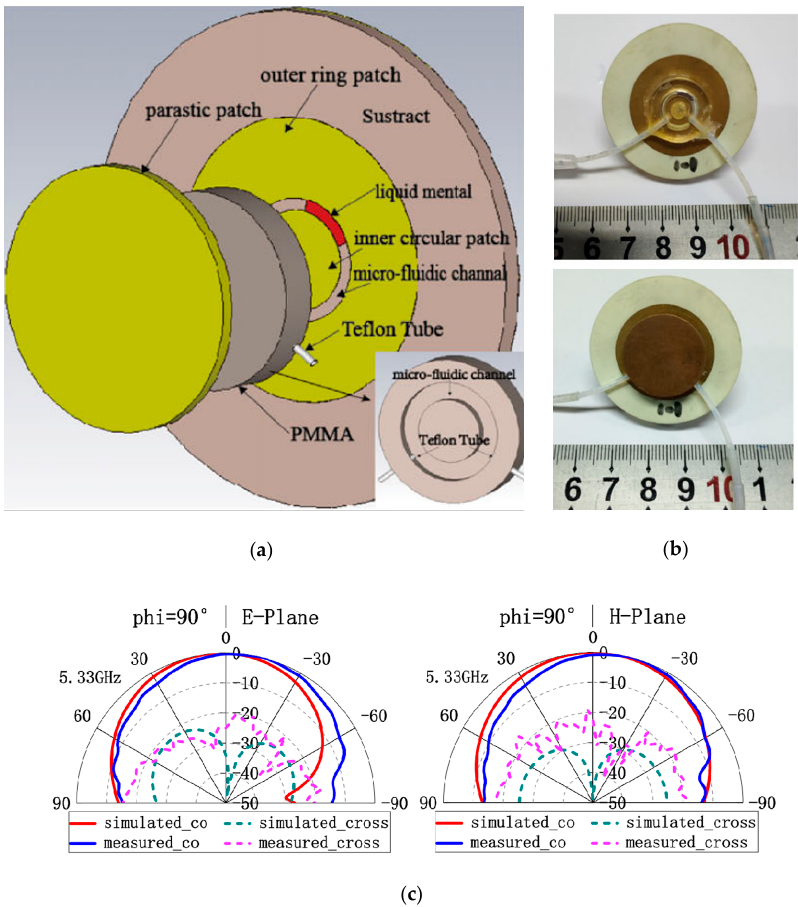
Figure 10. ( a ) 3D exploded design of the circular patch antenna depicting LM in PMMA microfluidic channel; ( b ) Fabricated antenna with and without covering of microfluidic channel; and ( c ) Measured and simulated co / cross-polarization patterns at 5.33 GHz